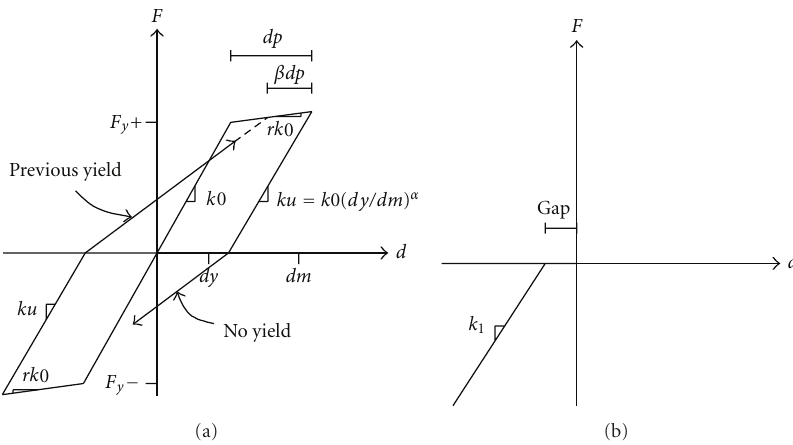
Figure 5: Models for (a) hysteretic behaviour of piers (Takeda model) and (b) gap element between adjacent structural segments.